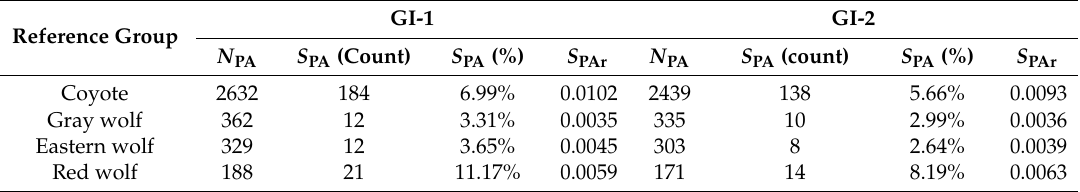
Table 2. Private allele sharing between reference groups and each Galveston Island, TX canid. Summary statistics for GI-1 and GI-2 were calculated over 6859 and 6391 genome-wide SNPs,